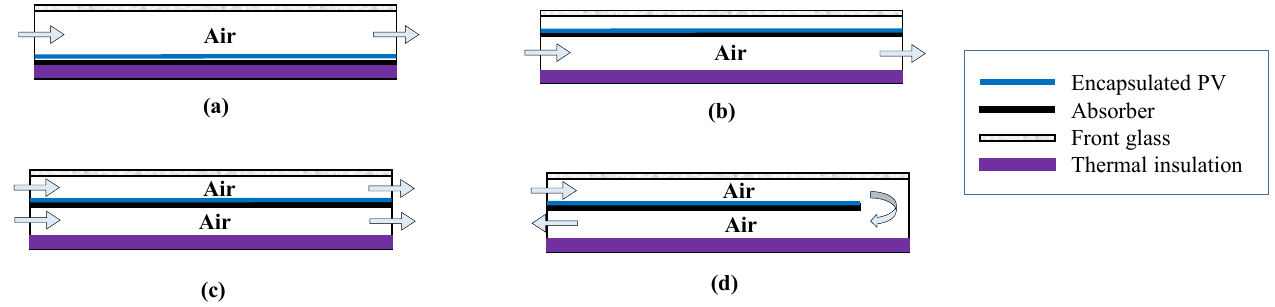
Figure 2. Four main types of air-based PV-T collector designs depending on the air channel configuration. ( a ) Channel above PV, ( b ) channel below PV, ( c ) PV between single-pass channels and ( d ) double-pass design. (Adapted with permission from [26]. Copyright 2009 Elsevier Ltd.).